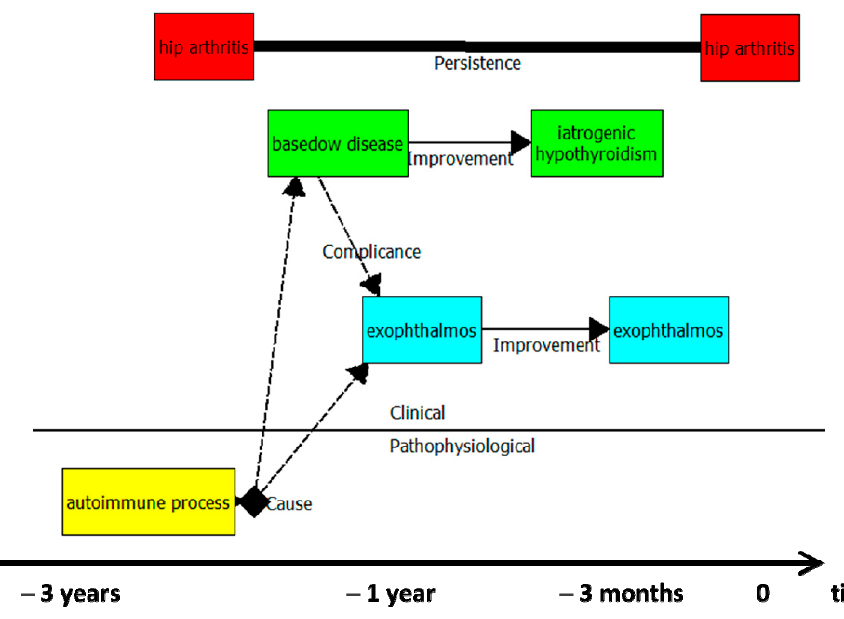
Figure 1. The primitives are linked to colours, levels, and time.